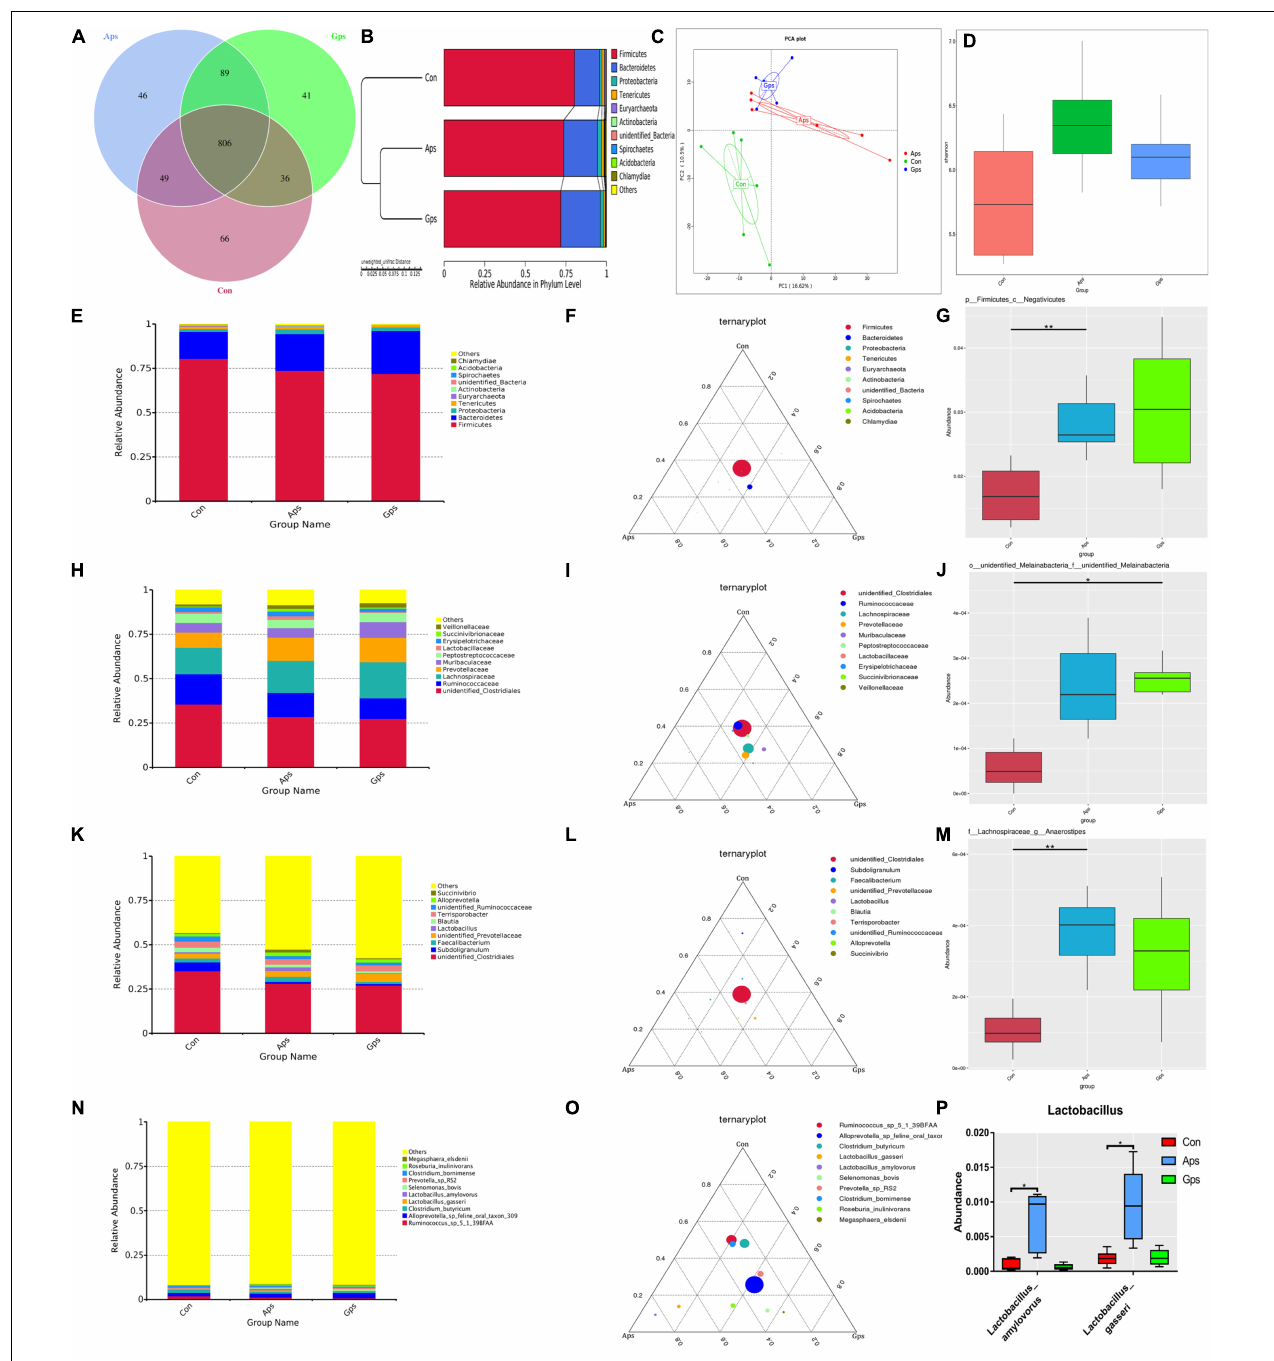
FIGURE 6 | Summary of microbial community in colon contents of weaned piglets. (A) Represents the Venn diagram summarizing the numbers of common and unique OTUs in the microflora community in colonic contents of weaning piglets. (B) Represents UPGMA Cluster Tree displaying the relative abundances of predominant bacteria at the species level in each group (unweighted UniFrac distance). (C) Represents principle component analysis (PCA) plot about the colonic microflora. (D) Represents shannon index reflecting species diversity within and between groups. (E,H,K,N) Represent the top 10 relative abundance of microflora community (level phylum, family, genus, species). (F,I,L,O) Represent differences of dominant species between groups (level phylum, family, genus, species). (G,J,M,P) Represent a species with significant differences between groups (level phylum, family, genus, species). Con represents the control piglets; Aps represents the piglets supplemented with the astragalus polysaccharide; Gps represents the piglets supplemented with ginseng polysaccharide. OTU, operational taxonomic unit. Piglets were regarded as the experimental units, each treatment with n = 6. ∗ Means different ( P < 0.05), ∗∗ means significant difference ( P < 0.01).